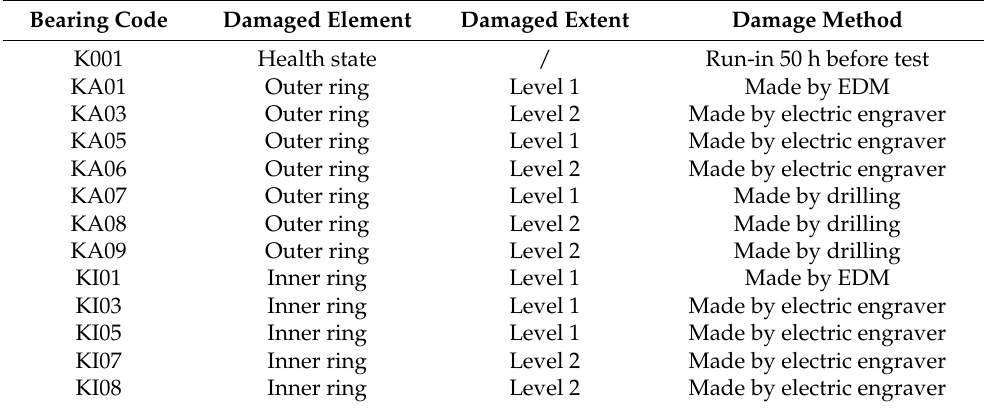
Table 2. Dataset 1: Unlabeled artificially damaged bearing dataset under N15_M01_F10. Bearing